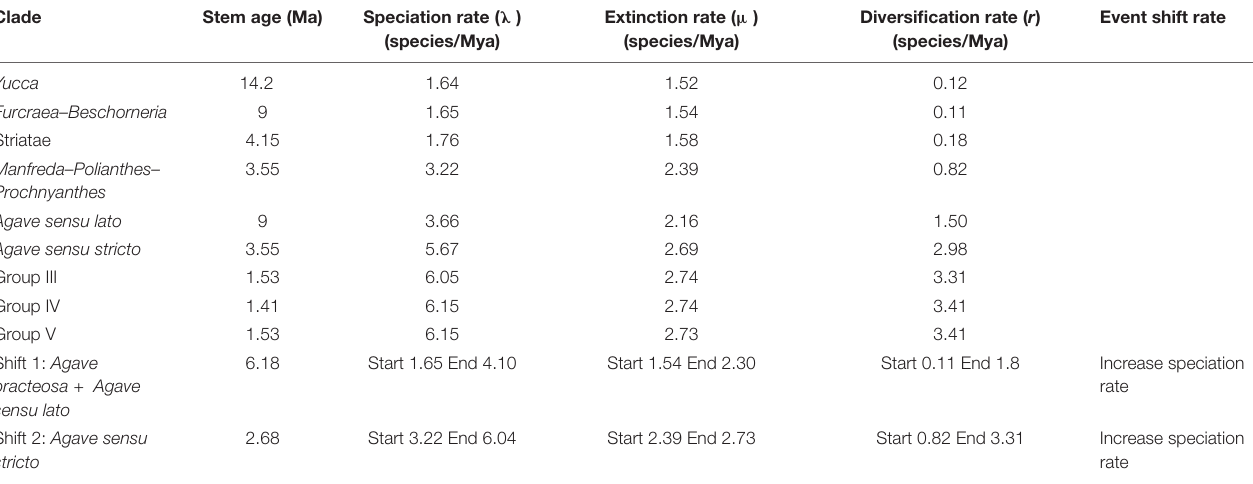
TABLE 2 | Significant shifts in diversification rate where r is the diversification rate = ( λ − µ ). Clade Stem age (Ma) Speciation rate ( λ )